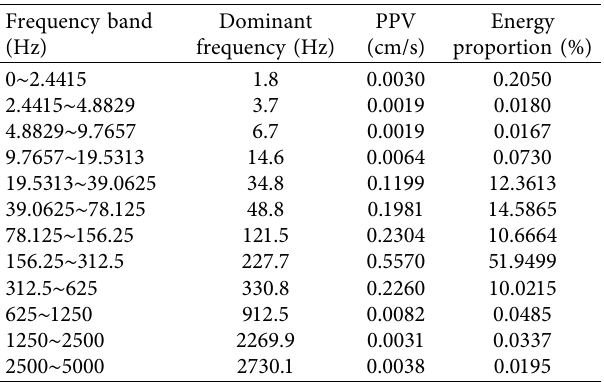
Table 9: Dominant frequency, PPV, and energy proportion of each subfrequency band at measuring point 5 in the far zone. Frequency band